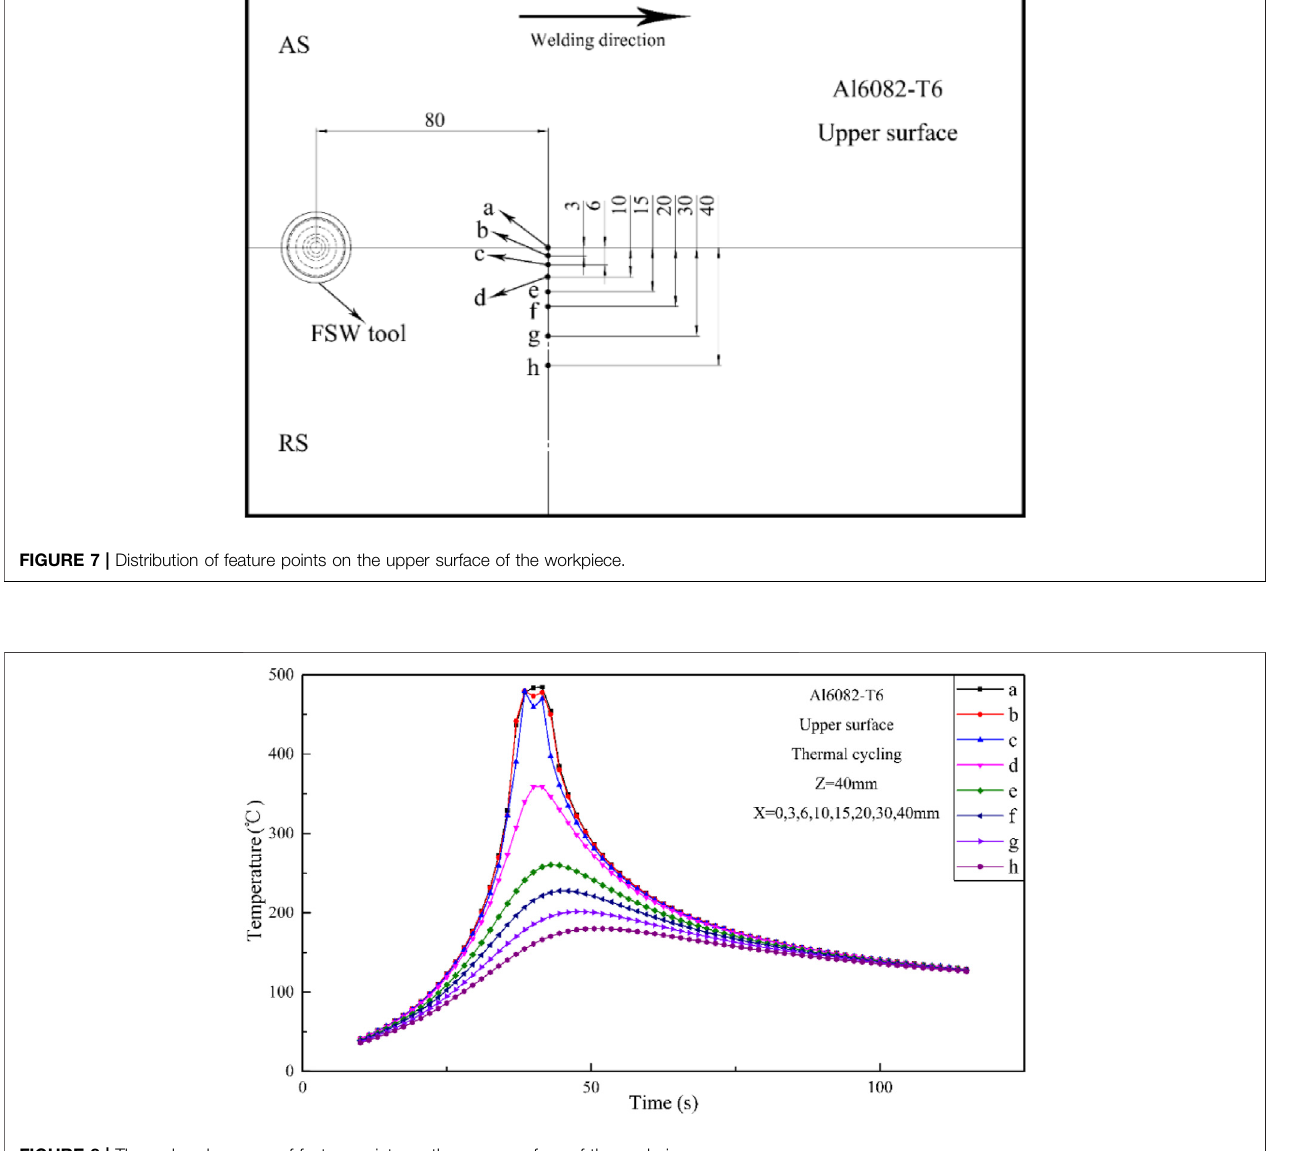
Frontiers in Materials |